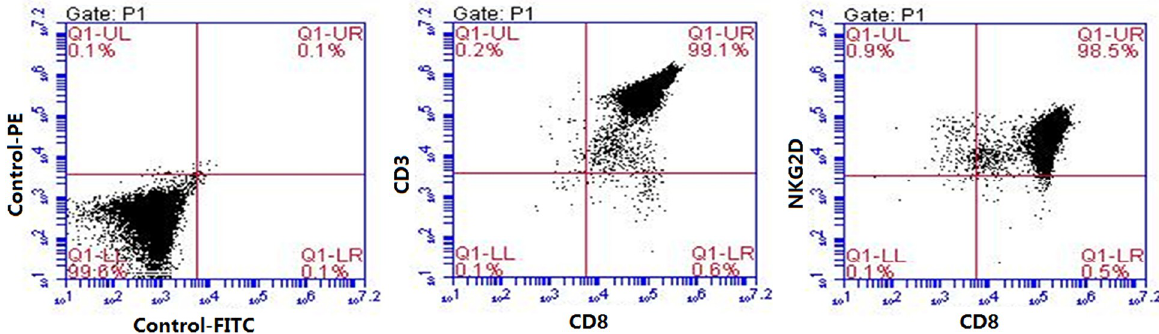
Fig 1. Analysis of CD8 + cell purity by flow cytometry. CD8+ CIK cells were labeledwith anti-CD8/CD3 and CD8/NKG2D specific fluorescent antibodyand subjectedto flow cytometry. The control group (control) was treated with PBS instead of antibody. Shownare representative images of cells from Donor 5.